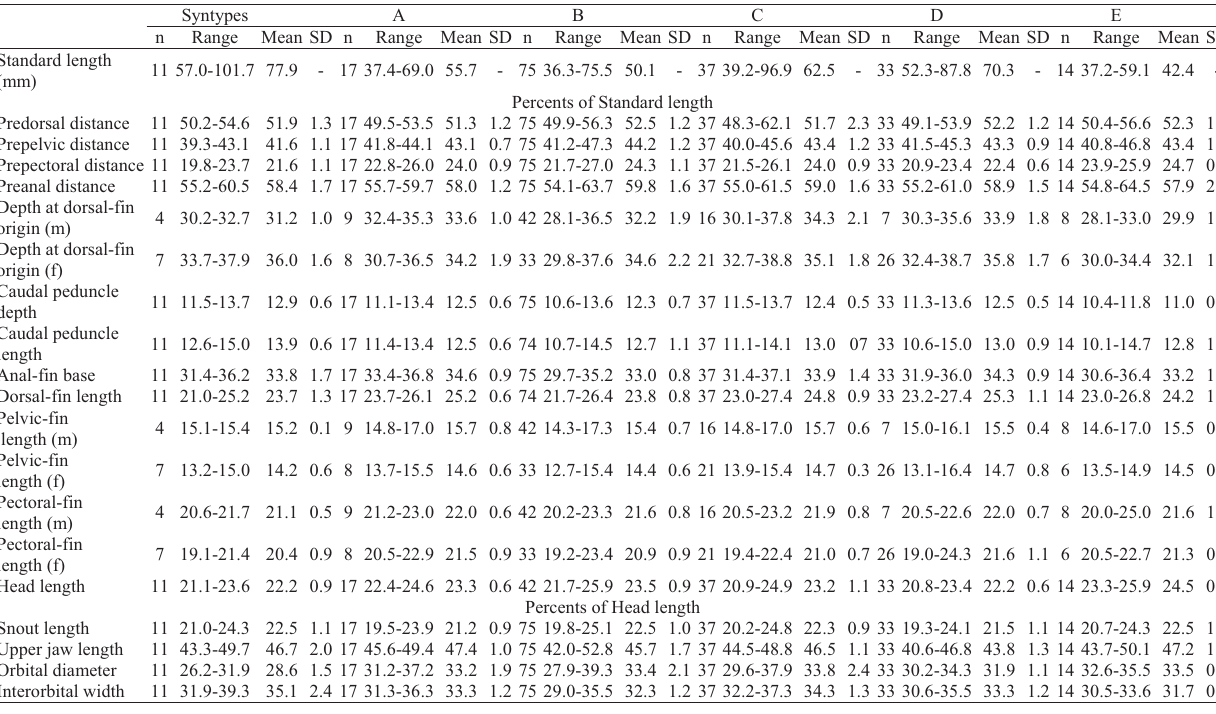
Table 3. Morphometric data of syntypes of Hemibrycon jelskii (NMW 57548, 57551, 57554) and non-types from río Ucayali basin, Peru (A - ANSP180772; MUSM 2958, 17261, 19562; MHNG 218265), from río Chapare basin, Bolivia (B - MCP 35019, 35020, 35021, 35022; MZUSP 27827; MNHN 1989.1418), from río Madre de Dios basin, Cochabamba, Bolivia (C - MUSM 3759, 11080, 26409, 26785; ROM 66370), from río Huancabamba, río Marañon basin, Peru (D - MUSM 2166; ROM 52240), and from río Beni basin, Bolivia (E - CAS 70081; MNHN 1989.1417). m, males; f, females. SD = Standard